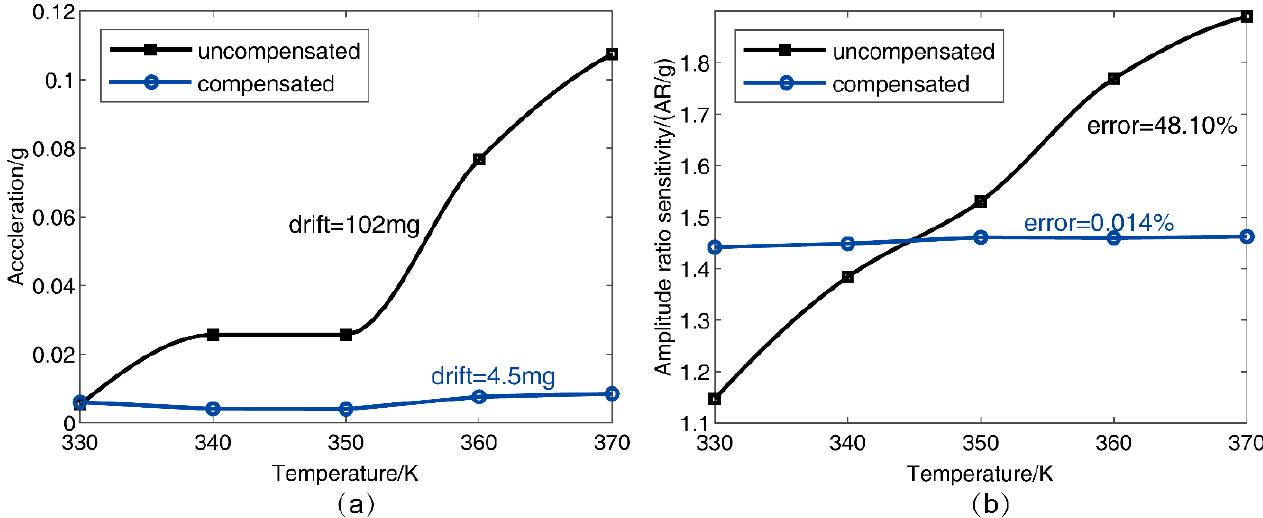
Figure 14. The experimental results of the accelerometer temperature compensation at the accelerometer of ( a ) zero bias 0 g, and ( b ) sensitivity.